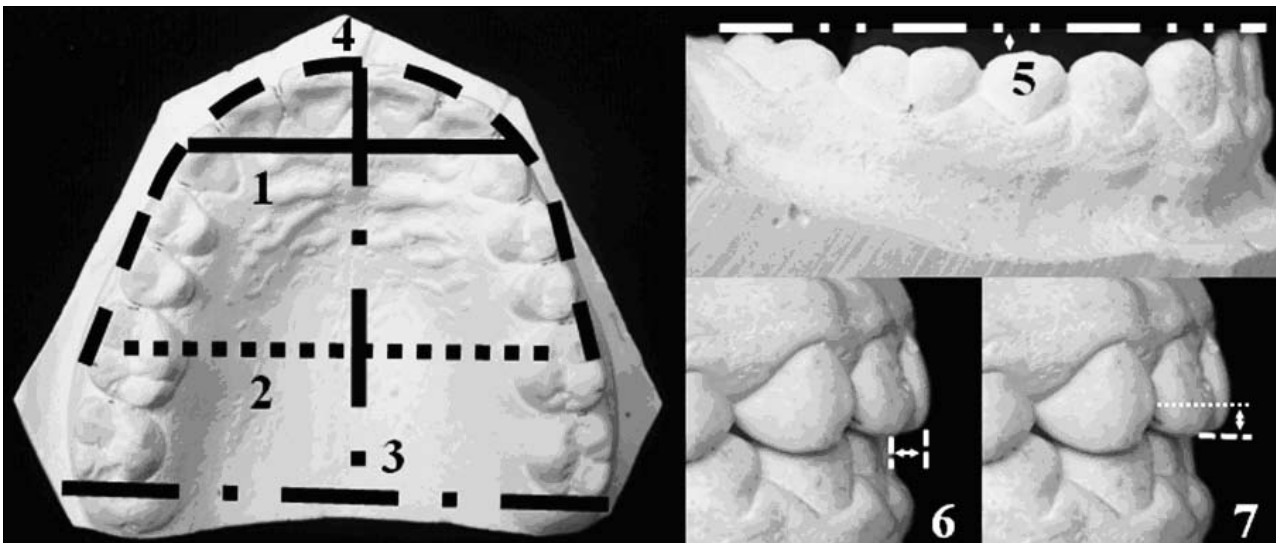
Figure 1. Measurements in cast models: 1. Intercanine width. 2. Intermolar width; 3. Arch length; 4. Perimeter of arch; Table 1. Comparison of the dental arches between Mazahuas and mestizos by genders (12 to 14 years old)